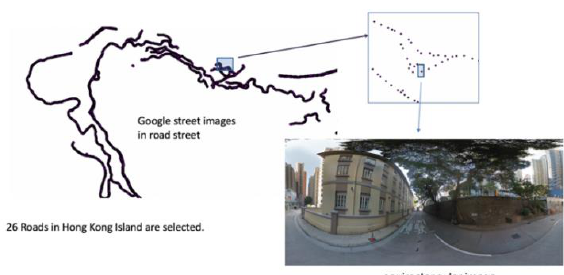
Figure 2. Download google street view images for 26 selected roads. Each dot represents the panorama photo in equirectangular format According to Google Maps REST API (Google map. 2019), data of panorama photos have been downloaded. We initially use road polygon from open data (Lands Department. 2017) to sample the positions of panorama photos and download the images along each road. In Figure 2, the lines from the left correspond to the roads and each dot represents the position of google street panorama view. Each view provides both the equirectangular image for whole scene in 360° view and the depth map.